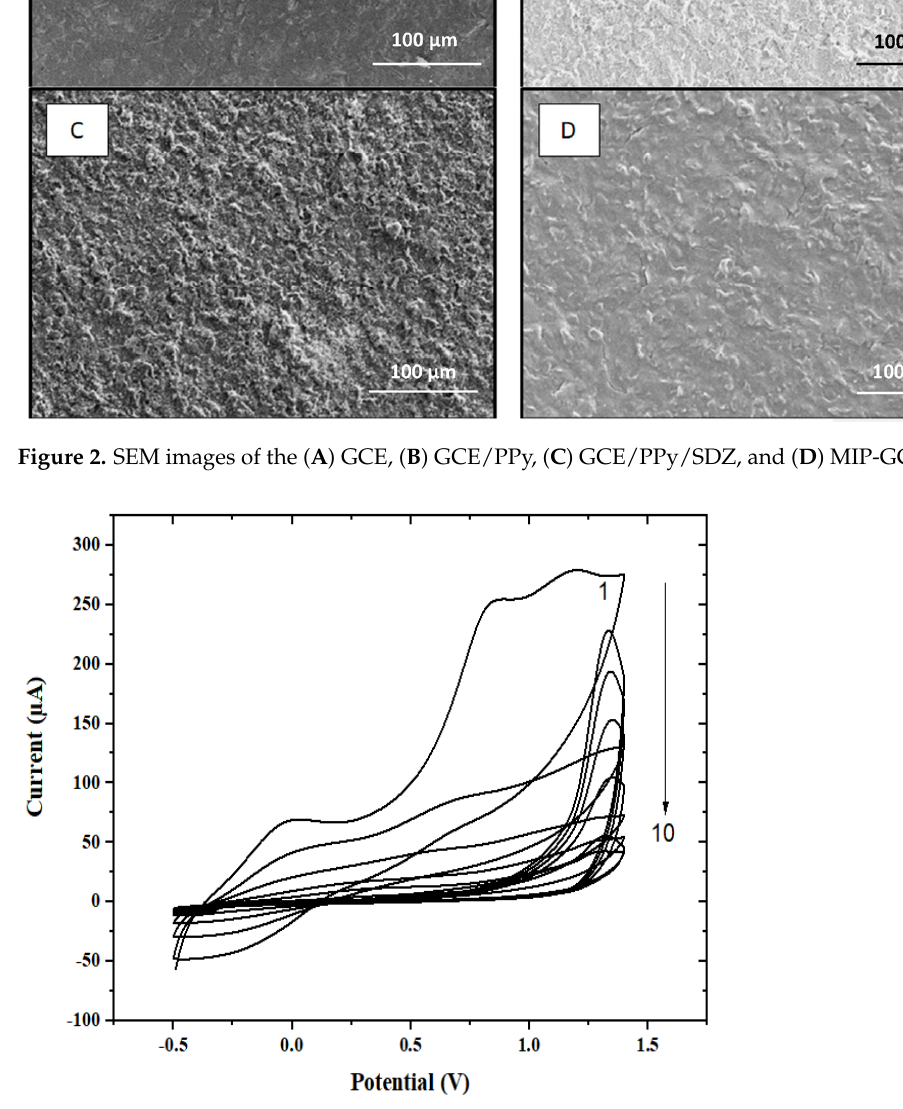
Figure 3. Overoxidation of the imprinted PPy for the extraction of SDZ in 0.1 mol L − 1 NaOH solution.